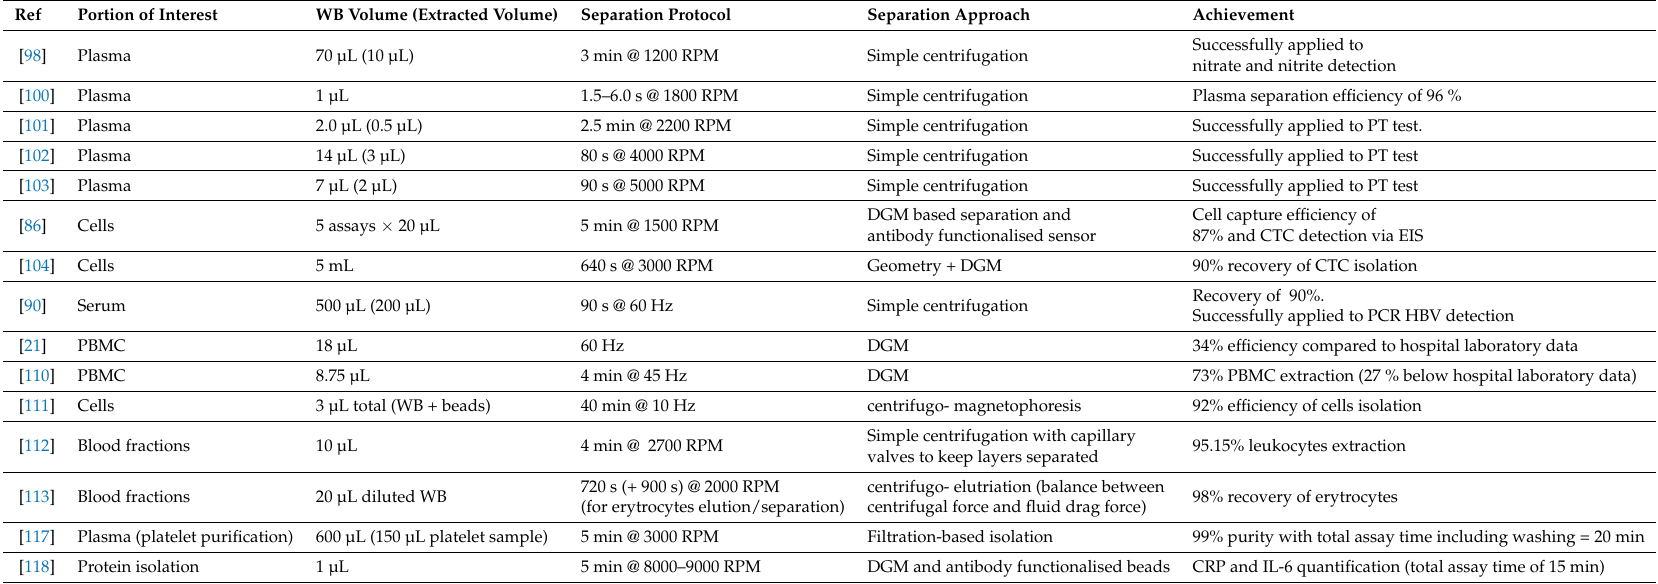
Table 1. Summary of the blood separation strategies performed in LoaD platforms. WB: whole blood, DGM: density gradient medium, PT: prothrombin time, HBV: hepatitis B virus, PBMC: peripheral blood mononuclear cell, CTC: circulating tumour cells, CRP: C-reactive protein, IL-6: